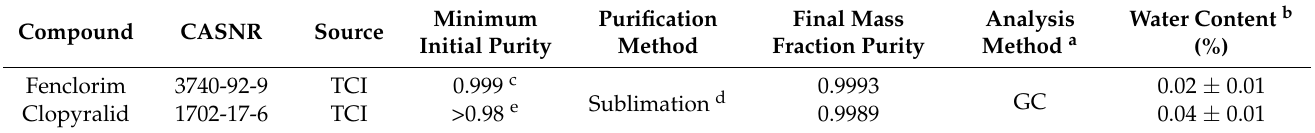
Table 1. Source, purity and methods of purification and analysis of the two compounds